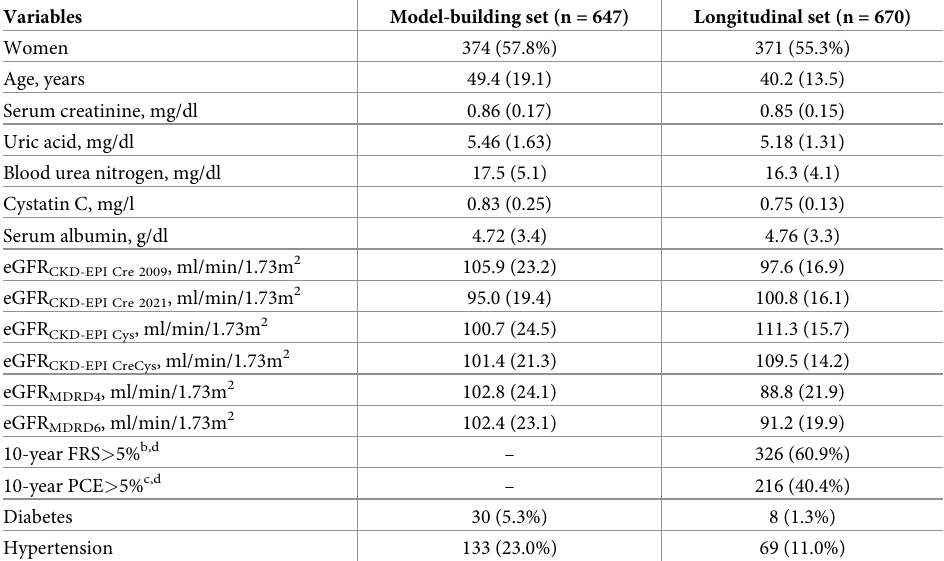
Table 1. Baseline characteristics of participants included in the model-building and the longitudinal sets a .